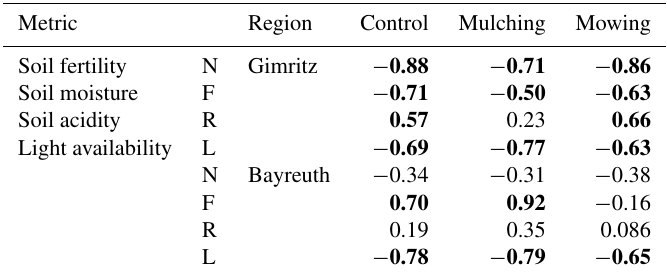
Table 3. Spearman rank correlations of the mean indicator values across years for Gimritz and Bayreuth. For each year and region, we used the mean of the indicator values across subplots. Significant values ( p <0.05) in bold. Note that because of the temporal autocorrelation these significance values are not strictly valid. Metric Region Control Mulching Mowing